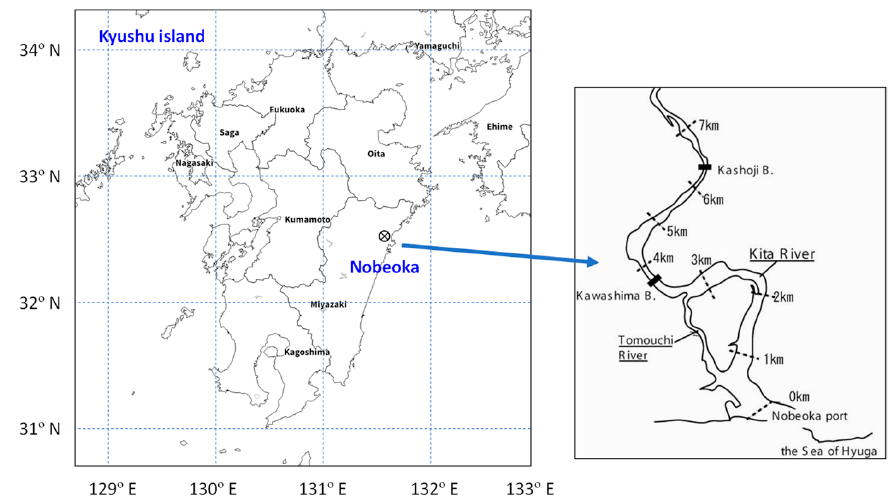
Figure 1. Map showing the sampling stations of Deiratonotus japonicus from the Kita River estuary.